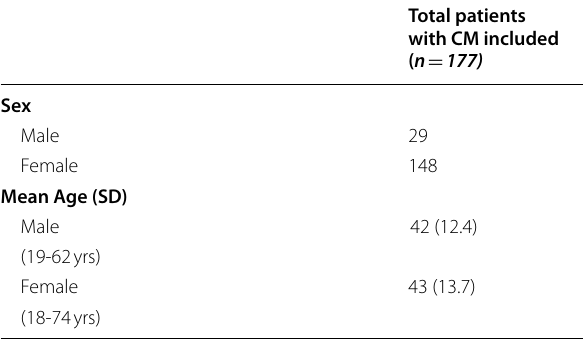
Table 1 Baseline Patient Demographics